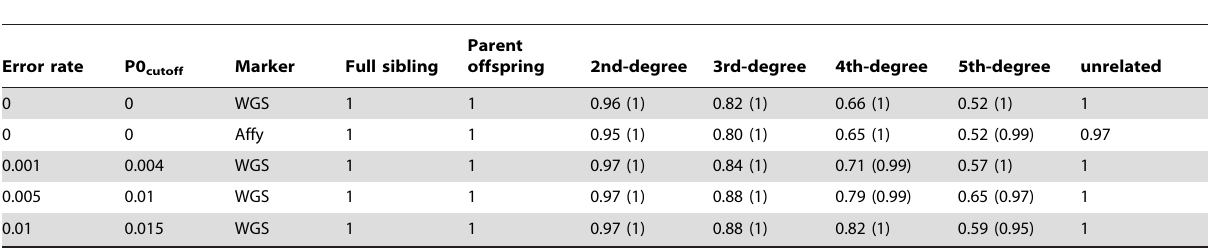
Table 2. Fraction of correct predictions for simulated